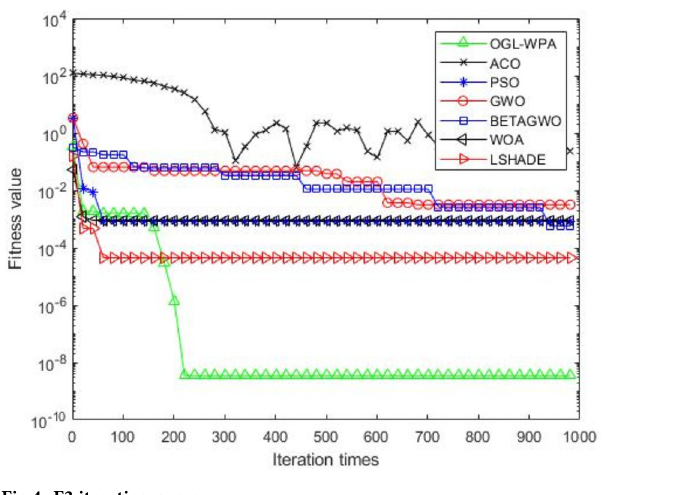
Fig 4. F3 iteration curve.